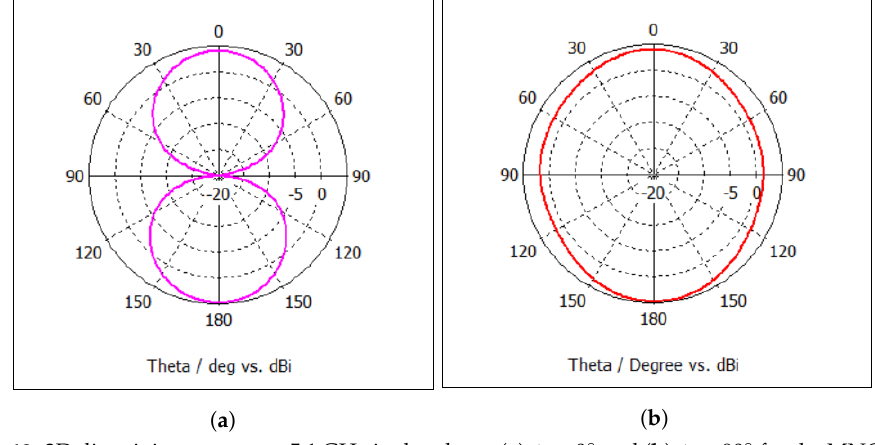
Figure 13. 2D directivity patterns at 5.1 GHz in the planes ( a ) φ = 0 ◦ and ( b ) φ = 90 ◦ for the MNG-ENG structure with the ENG region having ε r = − 2.0 and the capacitors of the tunable SRR-based MNG metasurface being set at 1.0 pF and the dipole antenna oriented along the